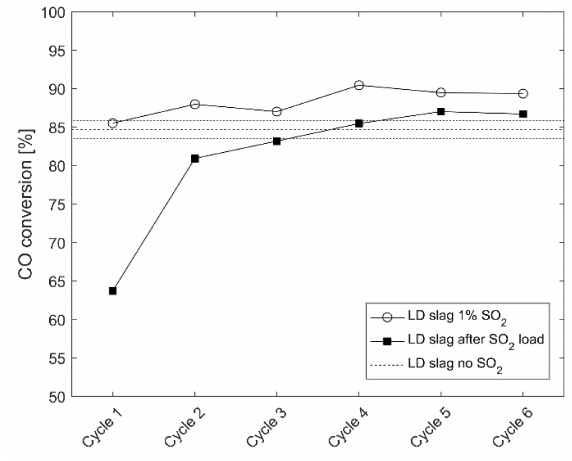
Figure 14. CO conversion for cycles using LD slag as bed material at 870 ◦ C. The horizontal dotted line is the reference with the mean and variance of cycles reduced with 50% syngas (50% CO in H 2 ) diluted with N 2 . Firstly, - - shows the CO conversion for six cycles reduced with1% SO 2 and 50% (cid:35) syngas with N 2 as a balance. Here, a slight increase in CO conversion can be observed for every cycle. The sample was then loaded with a high amount of sulfur using 1.5% SO 2 during the oxidation for 90 min. Thereafter, - (cid:4) - shows the CO conversion rate for the sample reduced using 50% syngas diluted with N 2 for six cycles, the same as the reference experiments. Here, it was observed that the conversion of the first reduction was much lower than in the following cycles where the conversion was similar to the reference or slightly higher.